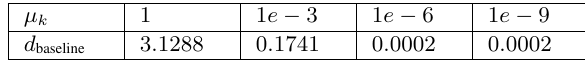
Table 5: Absolute distance in mm between the length of the cal- ibrated baseline and the mean of the reconstructed baselines for the case that the stereo constraint is enforced during the SfM re- construction.